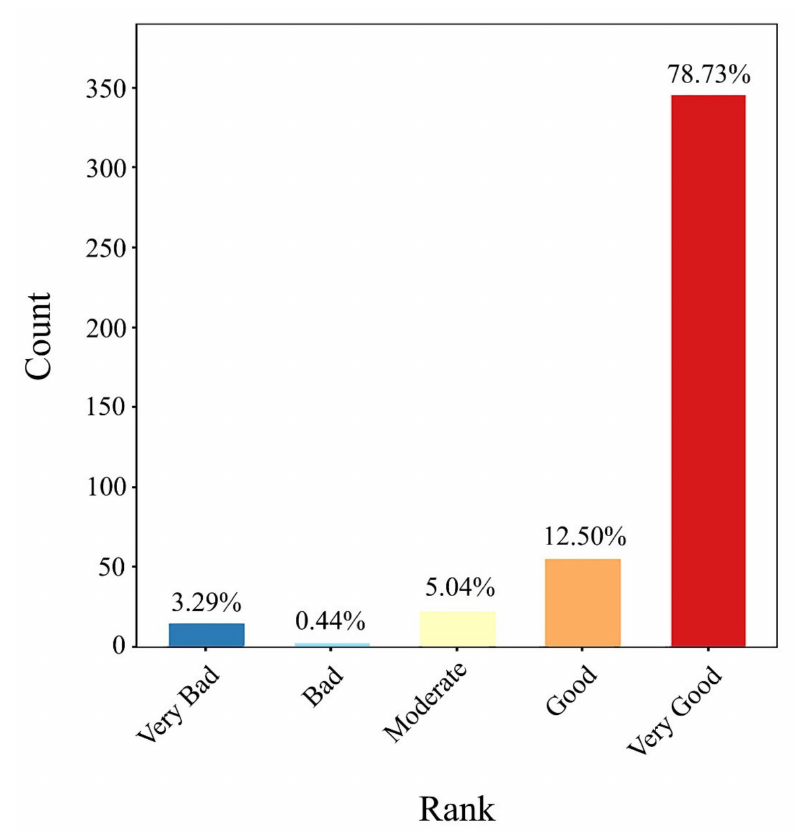
Figure 15. Displacement quality rank statistics of generalization